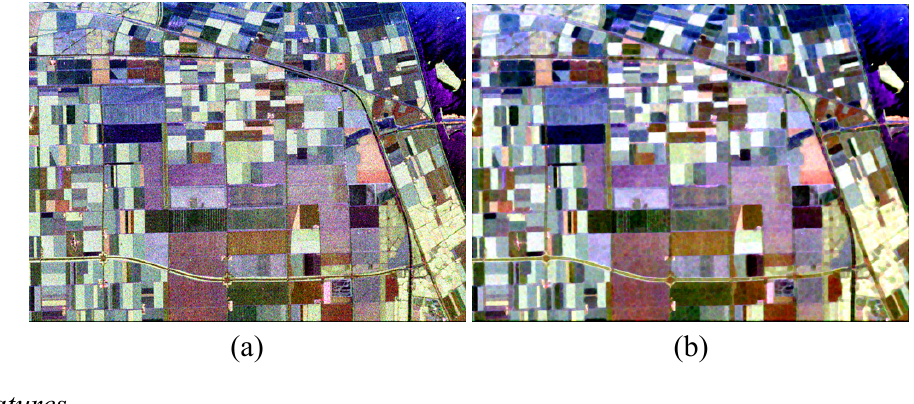
Figure 7. Pauli Image of Flevoland (1,024 × 750). ( a ) Pauli Image; ( b ) The refine Lee filtered images.